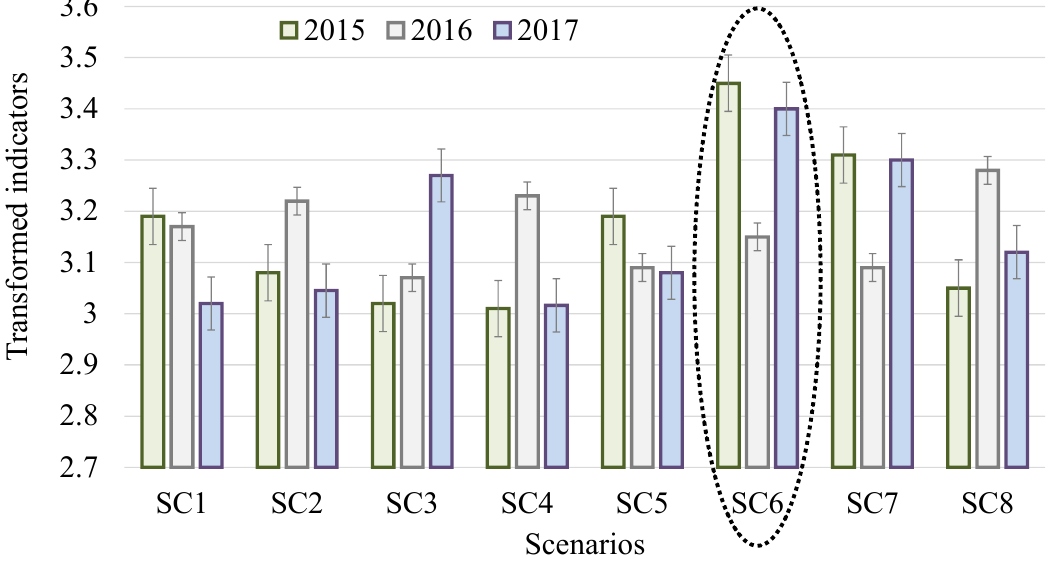
Figure 12. Multicriteria evaluation of the bio-impact effectiveness.